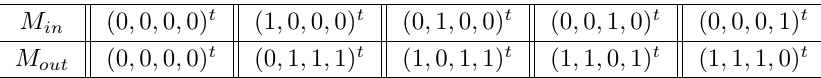
Table 2: All Deterministic Patterns ( M in , M out